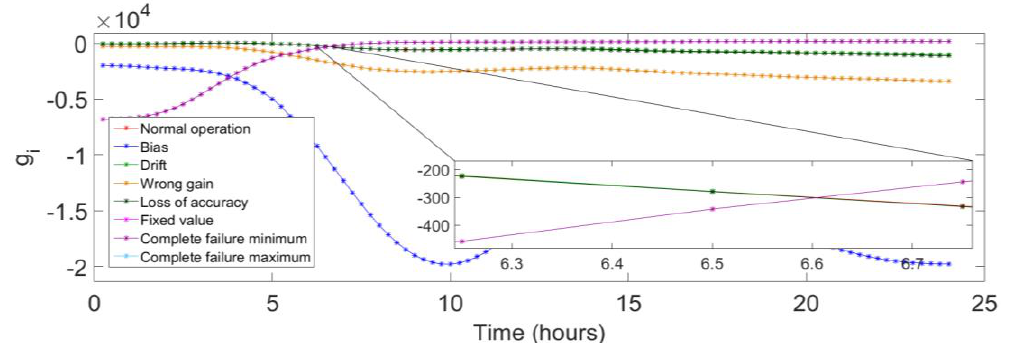
Figure 8. Complete failure minimum diagnosis: graphs of the FDA discriminant functions g i ( x ) for each of the normal and seven fault classes, along the 24 h of the 140th day and the detailed representation revealing the class of the observations and the time moment of the firm fault type identification. The complete failure maximum diagnosis is diagnosed successfully after 9.5 h, as is shown in Figure 9.